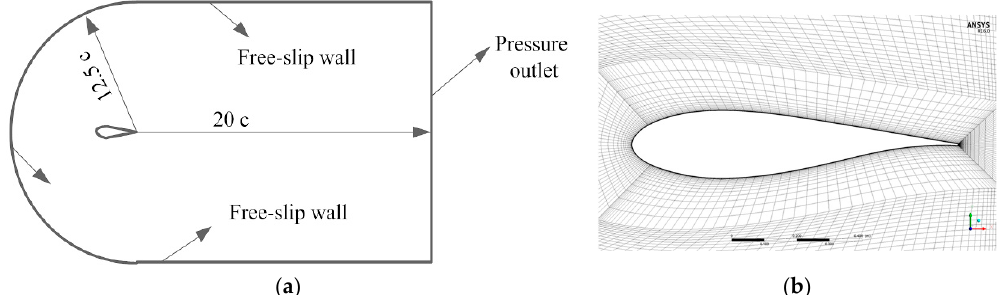
Figure 2. Scheme of the geometry and boundary conditions for the numerical simulation: ( a ) The semicircular far field is set as a velocity inlet located at 12.5 c (c is chord length) from the trailing edge of the airfoil, while the outlet condition is the pressure outlet located at 20 c from the trailing edge of the airfoil. ( b ) The boundary layer consists of 40 cell layers: the height of first layer is 1 × 10 − 6 ; the growth rate of the grid is 1.05 in the boundary layer.